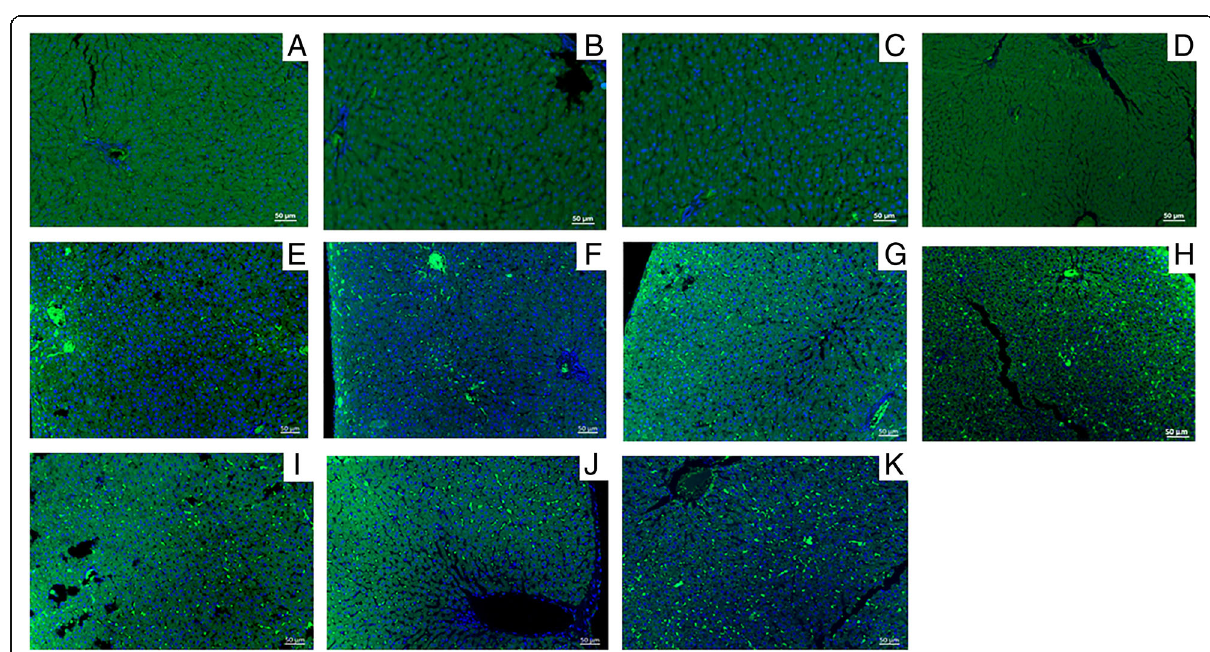
Fig. 4 Anti-MIF IF images of liver samples from the saline (negative control) and alcohol-induced steatohepatitis groups stained with green fluorescent compounds (ALEXA, AuNPs, or both) and DAPI (blue) for nuclei. a Negative control stained with ALEXA standard protocol (A1) with anti-MIF and ALEXA (green). b Negative control stained with ALEXA modified protocol (A2) with anti-MIF and ALEXA. c Negative control stained with nanoparticle protocol 1 (NP1) with anti-MIF and AuNPs (green) in place of ALEXA. d Negative control stained with nanoparticle protocol 2 (NP2) with anti-MIF and AuNPs in place of ALEXA. e Positive control stained with A1. f Positive control stained with A2. g Positive control stained with NP1. h Positive control stained with NP2. i Positive control stained with nanoparticle protocol 3 (NP3) with anti-MIF + AuNPs with 1:200 ALEXA. j Positive control stained with NP3 with a 1:400 dilution of ALEXA. k Positive control stained with NP3 with a 1:800 dilution of ALEXA. Magnifications, × 200. Scale bar = 50 μ